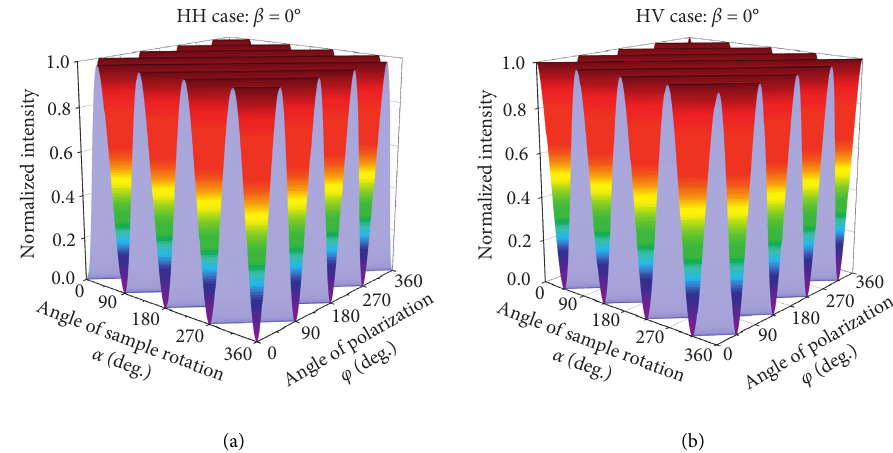
Figure 2: Raman intensity sum distribution of vertical backscattering under different sample rotation angles α and polarization directions φ / c of the (a) HH case and (b) HV